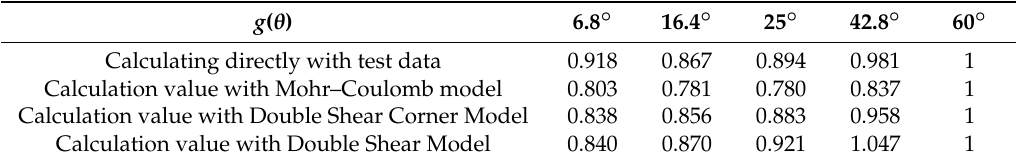
Table 6. The g ( θ ) on π plane whose hydrostatic stress is 32.8 MPa for 4.5% cement content cement-stabilized macadam.